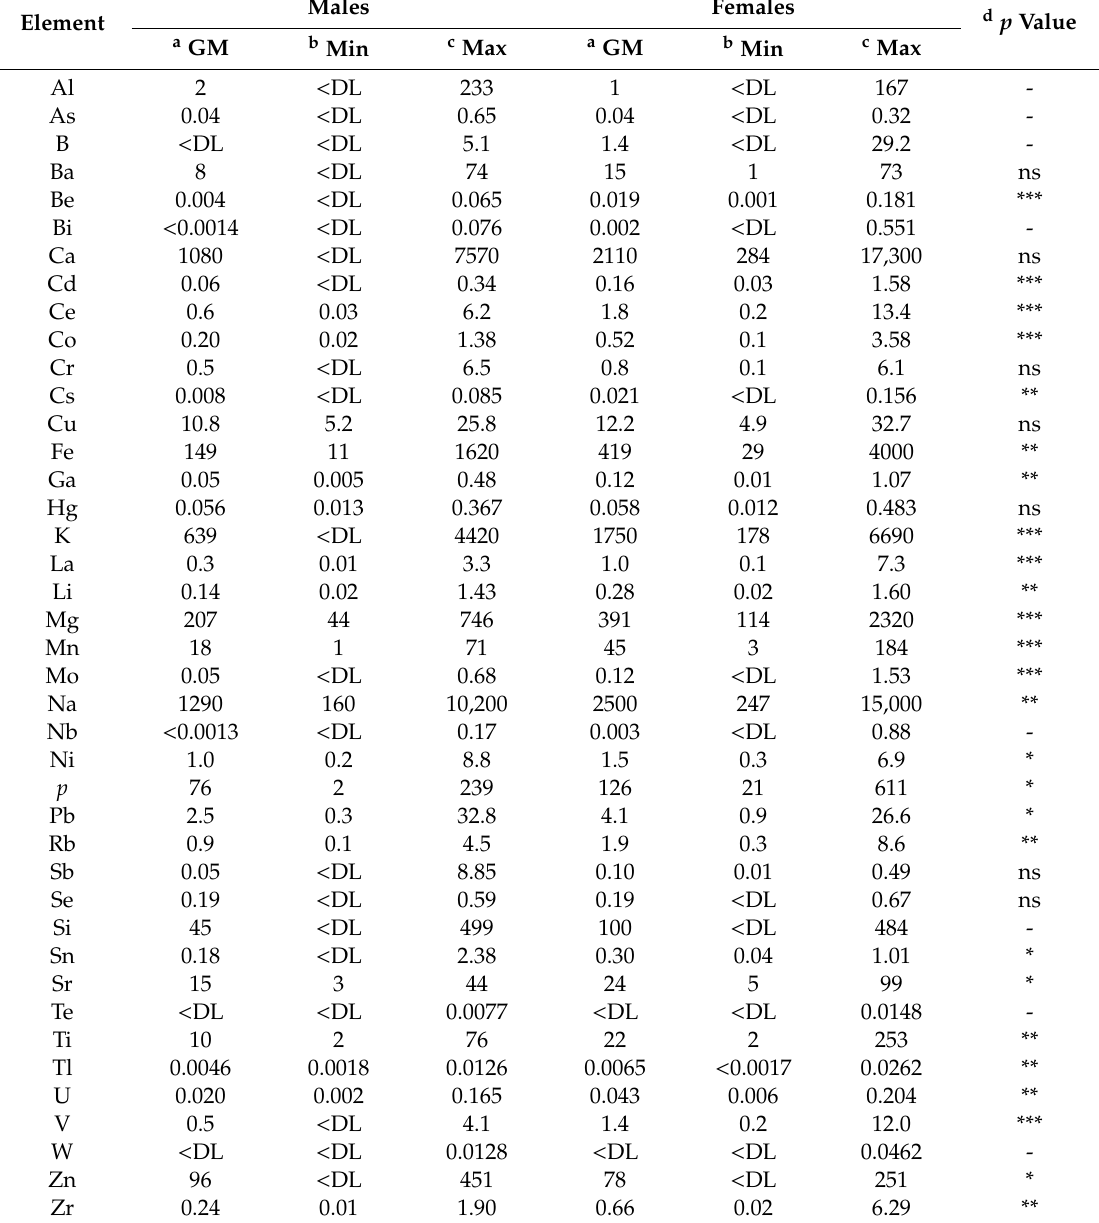
Table 3. Gender influence on element levels (mg kg − 1 ) in children’s